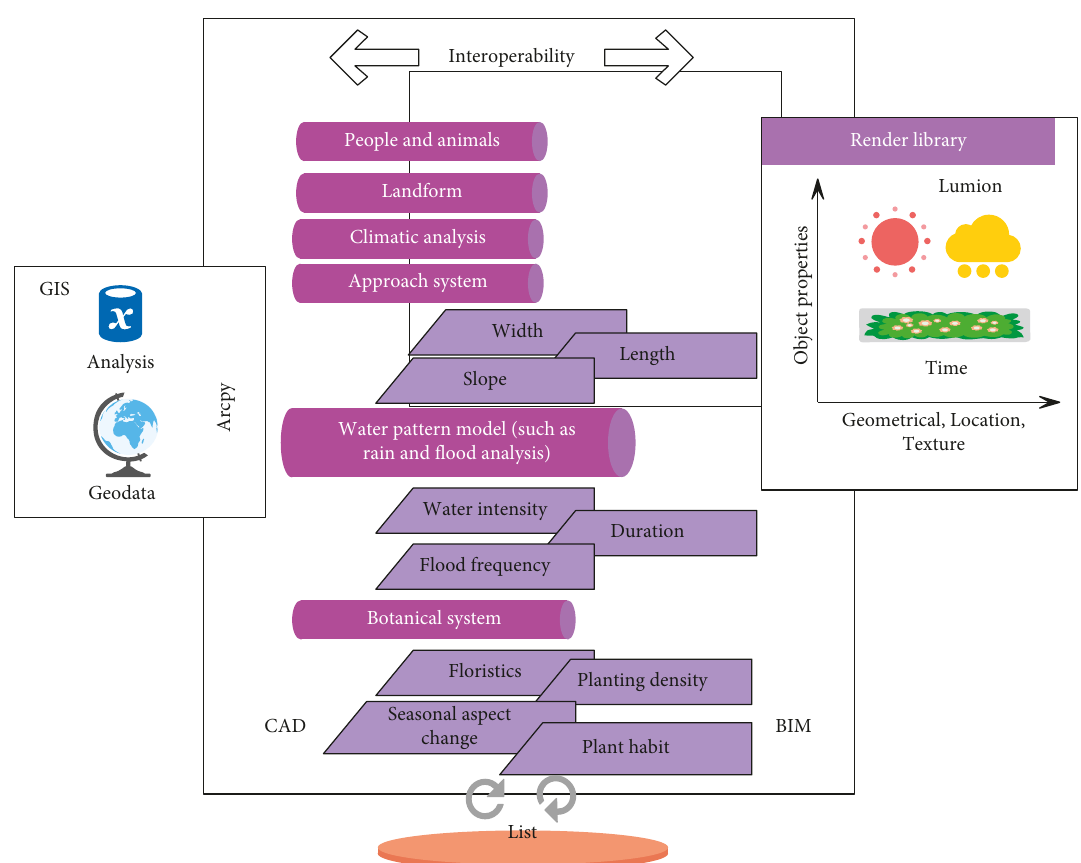
Figure 4: Landscape information model architecture.